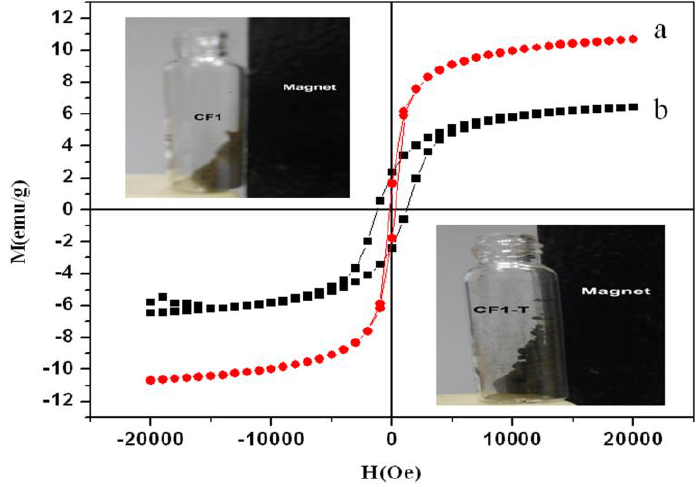
Figure 10. Magnetization M–H curves of: ( a ) the CoFe 2 O 4 -supported LDH and ( b ) the CoFe 2 O 4